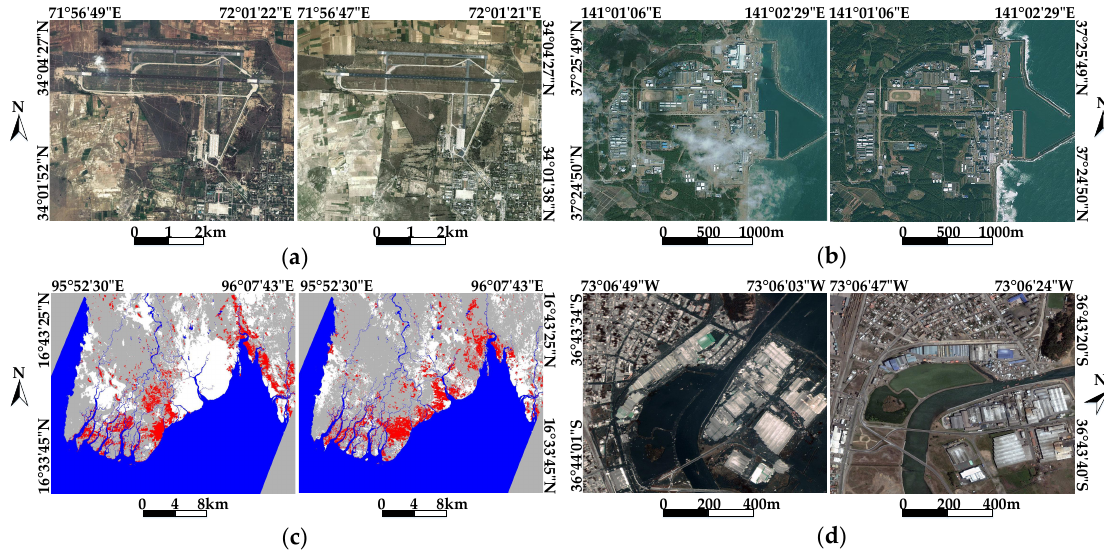
Figure 8. Illustration of real image pairs. ( a – d ) show the image pairs from Data set 2-1 to Data set